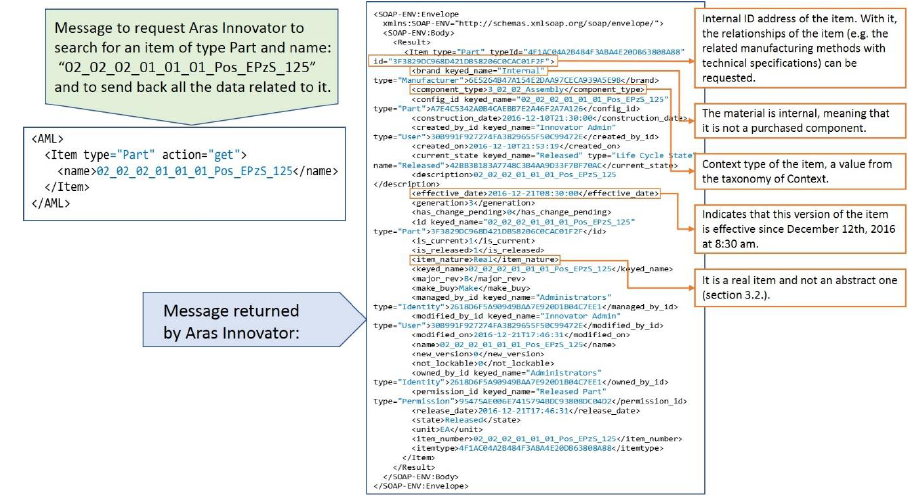
Figure 8. Example of communication with Aras Innovator.